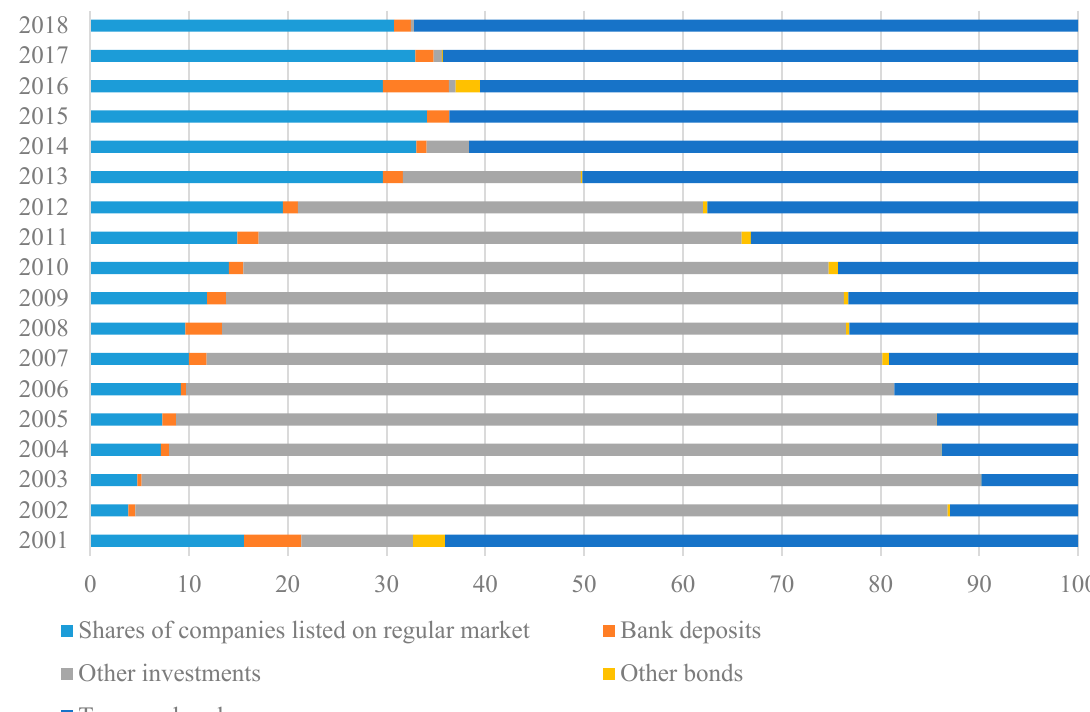
Figure 2. Structure of investment portfolio of employee pension funds (EPFs) in the Polish pension system, 2001–2018 (in %). Source: own study based on Komisja Nadzoru Finansowego, Publikacje i opracowania, Dane statystyczne, Rynek emerytalny, https://www.knf.gov.pl/publikacje_i_opracowania.